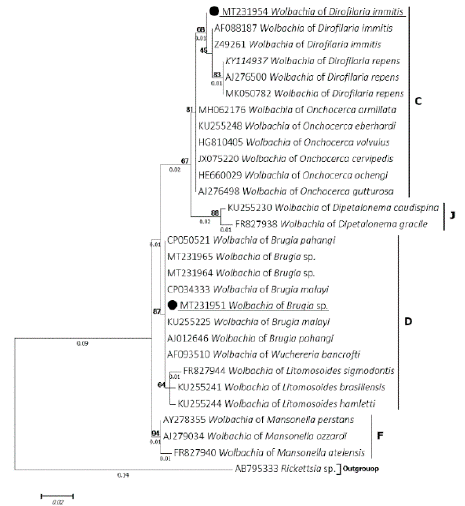
Figure 5. Phylogram of the Wolbachia 16S gene generated by maximum likelihood method from 29 partial (295) sequences. The tree with the highest log likelihood ( − 735.8600) is shown. A discrete